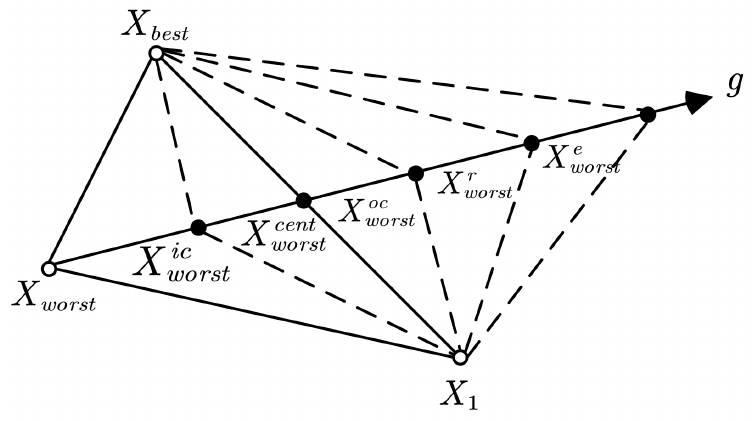
Figure 7. The location of different points in